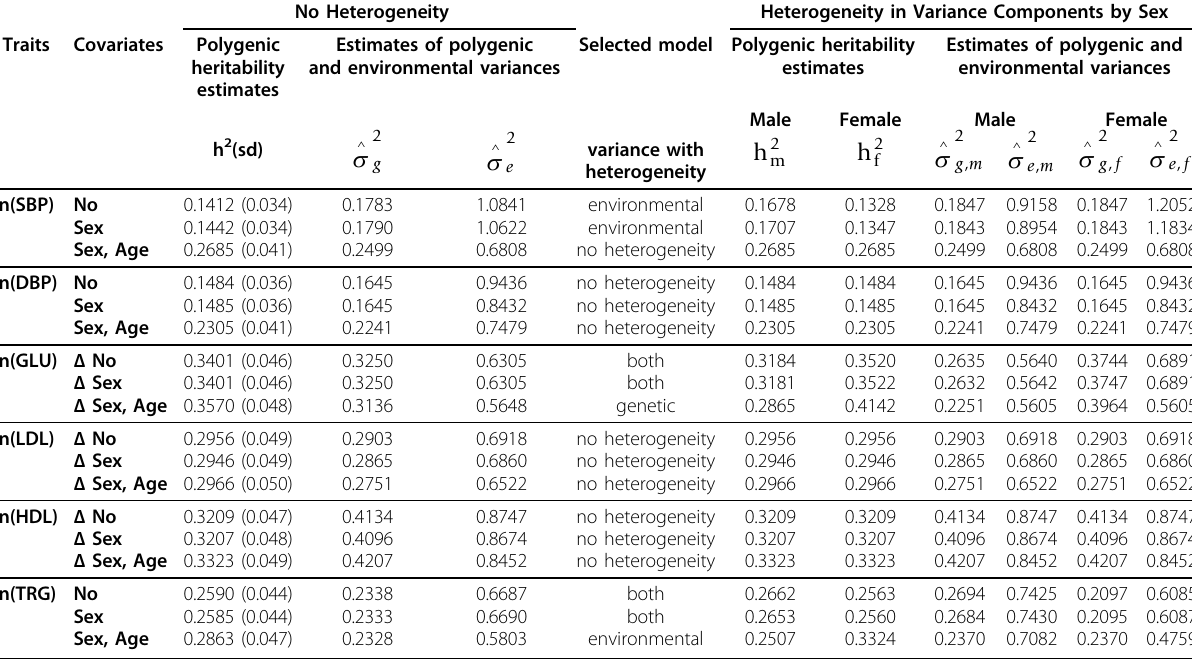
Table 3 Summary of the results obtained for models selected in the analysis of heterogeneity in variance components by sex No Heterogeneity Heterogeneity in Variance Components by Sex Traits Covariates Polygenic heritability